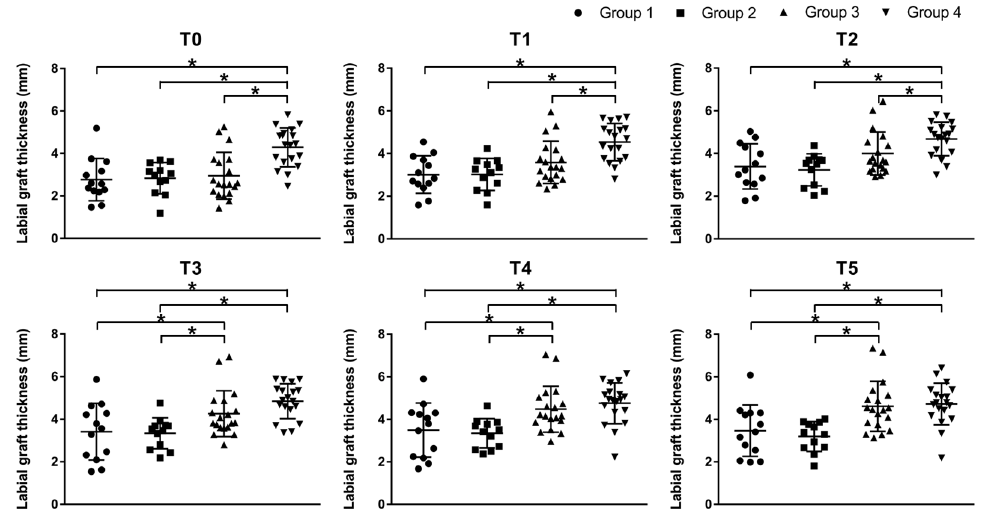
Figure 6. Quantification of labial graft thickness at different apico-coronal levels (T0–T5) immediately after wound closure. Error lines represent +/ − standard deviation. * Statistically significant.